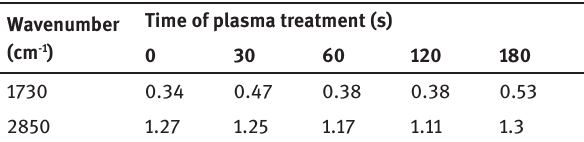
Table 4: Relative intensities for IR absorption bands (compared to 609 cm -1 ) of the plasma treated linen fabrics as a function of time of plasma treatment.